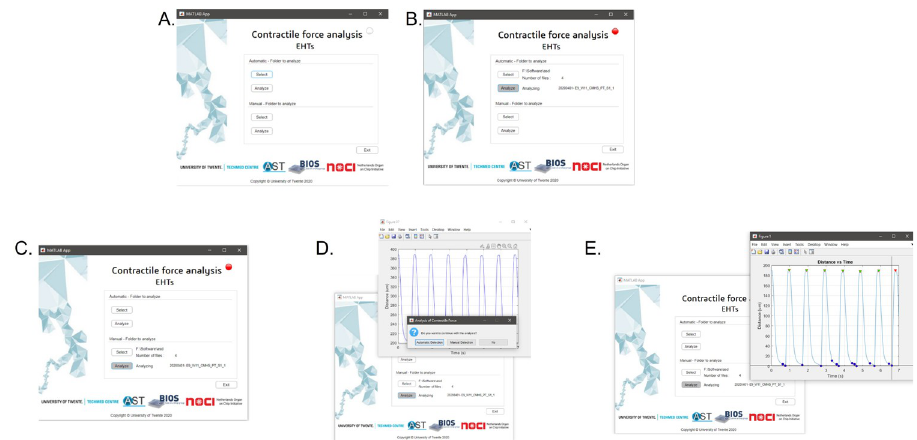
Fig 2. User interface EHT analysis . (A) Overview of the software. (B) Automatic contraction analysis option. (C-E) Manual contraction analysis per folder overview(C), selection of the analysis mode on preview contraction wave (automatic or manual) (D) and manually selection of maximums and minimums